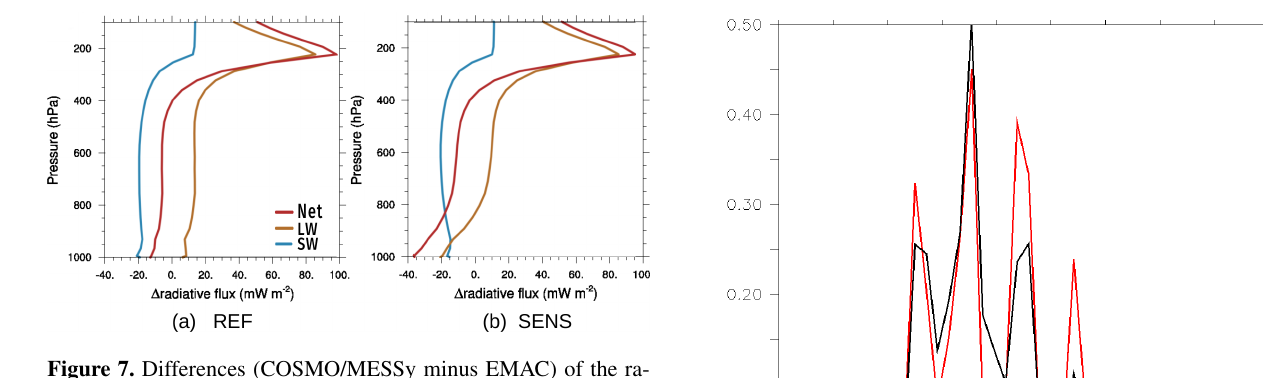
Figure 7. Differences (COSMO/MESSy minus EMAC) of the ra- diative fluxes (shortwave (sw), longwave (lw) and net) averaged over 35–60 ◦ N and − 10–30 ◦ E for July 2008. (a) REF simulation; (b) SENS simulation.